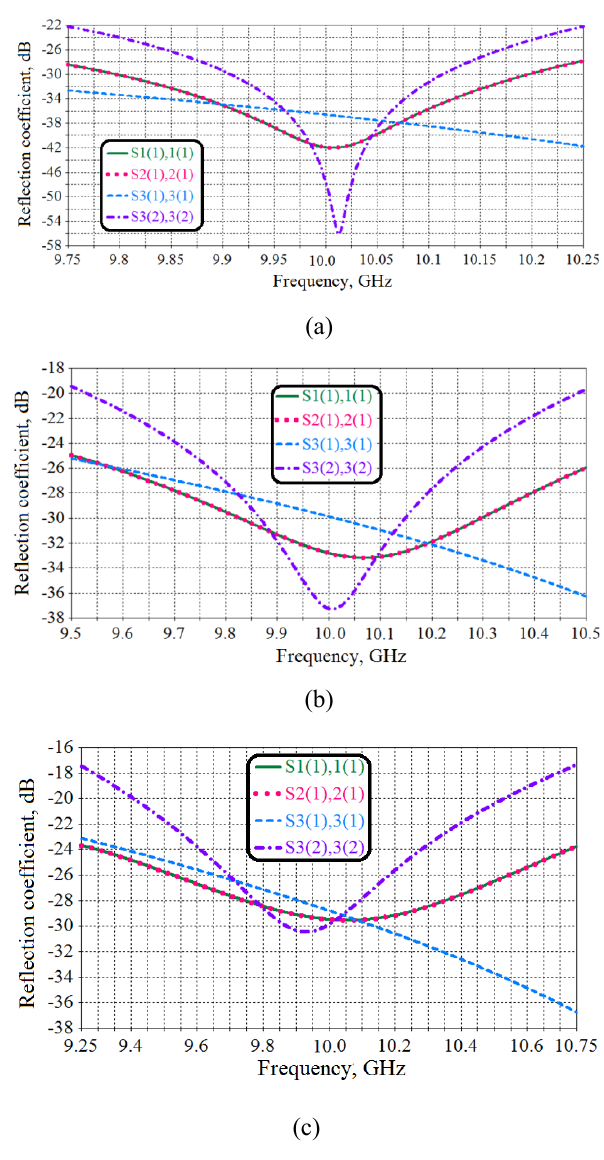
FIGURE 4. Dependences of the reflection coefficients of all 3 ports on frequency for different values of the fractional bandwidth: (a) 5% relative bandwidth; (b) 10% relative bandwidth; (c) 15% relative